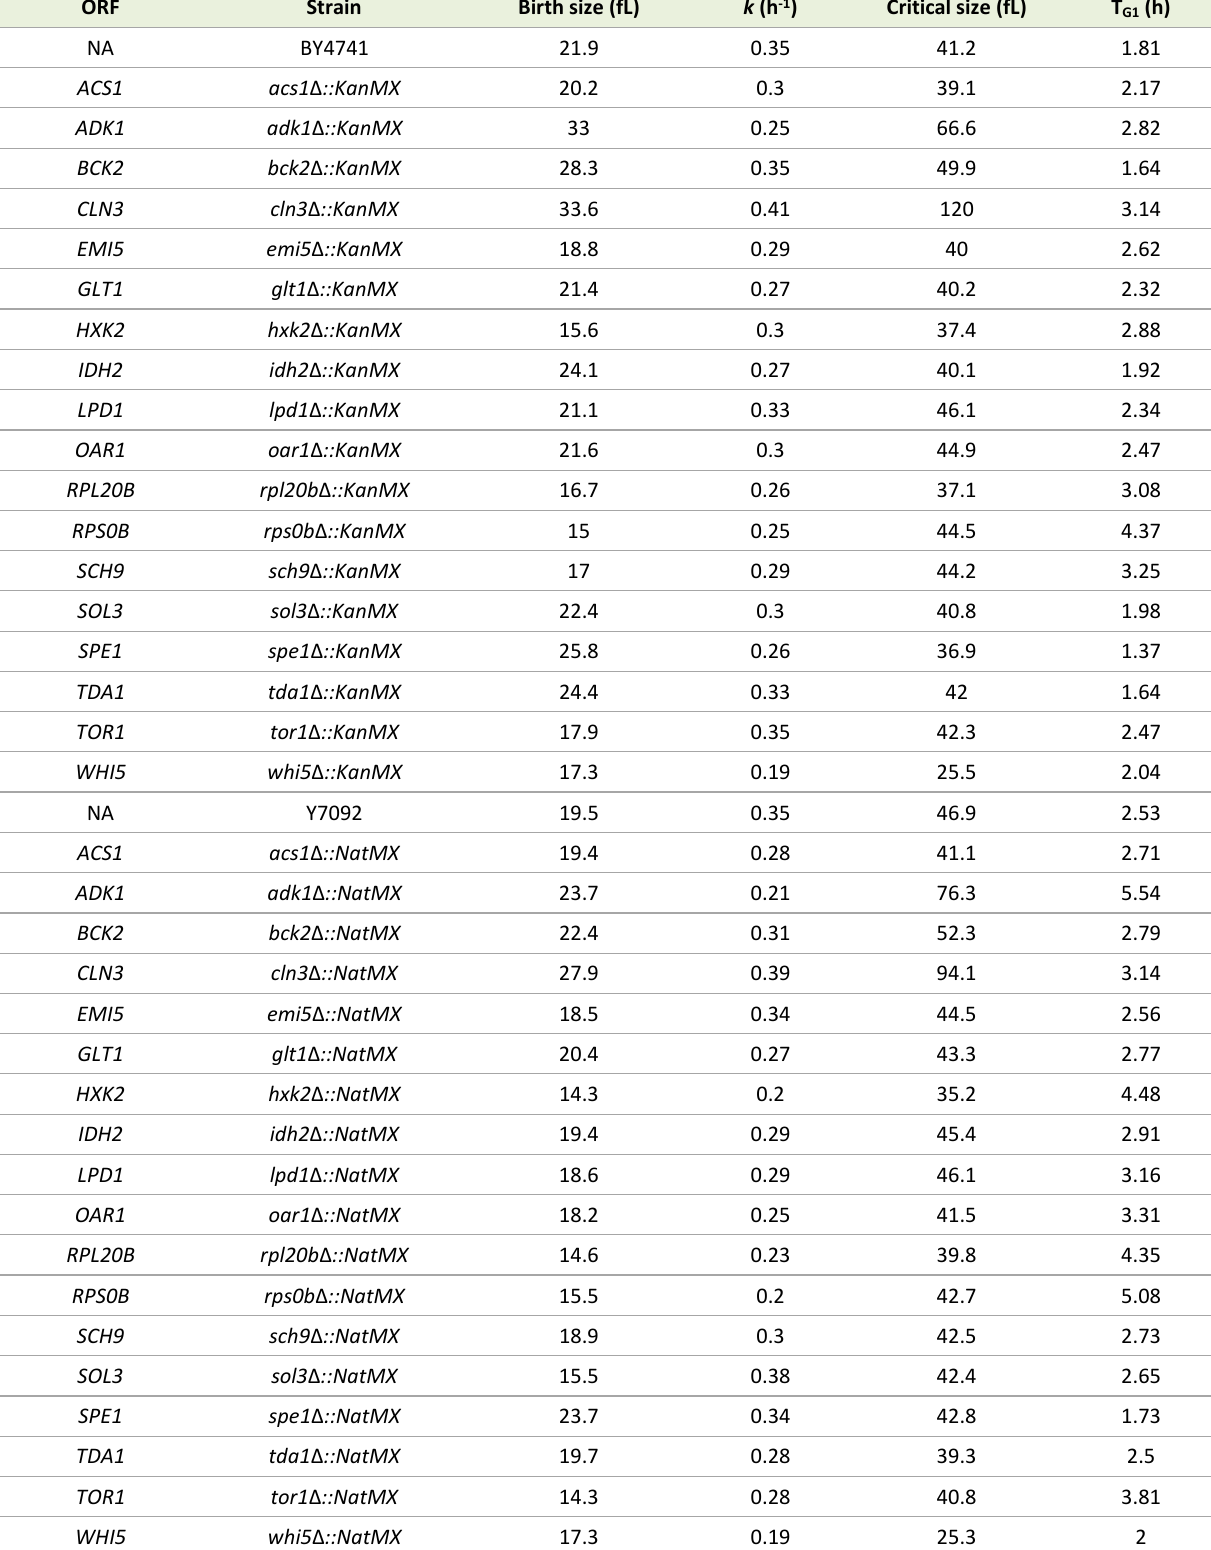
TABLE 2. G1 parameters of “growth” and cell cycle mutants a . ORF Strain Birth size (fL) k (h -1 ) Critical size (fL) T G1 (h) BY4741